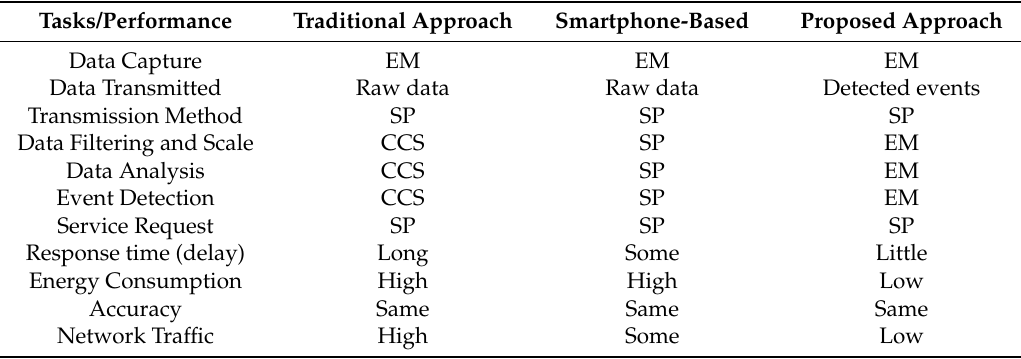
Table 1. Summary of alternative VF detection